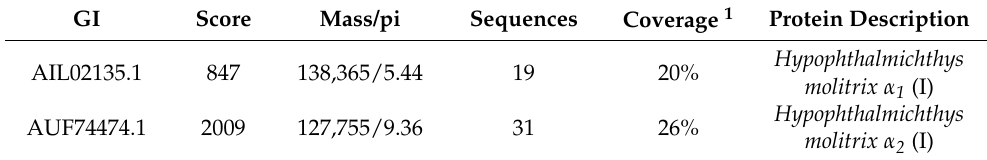
Table 1. Matching peptide coverage of SCSC amino acid sequences. GI Score Mass/pi Sequences Coverage 1 Protein Description